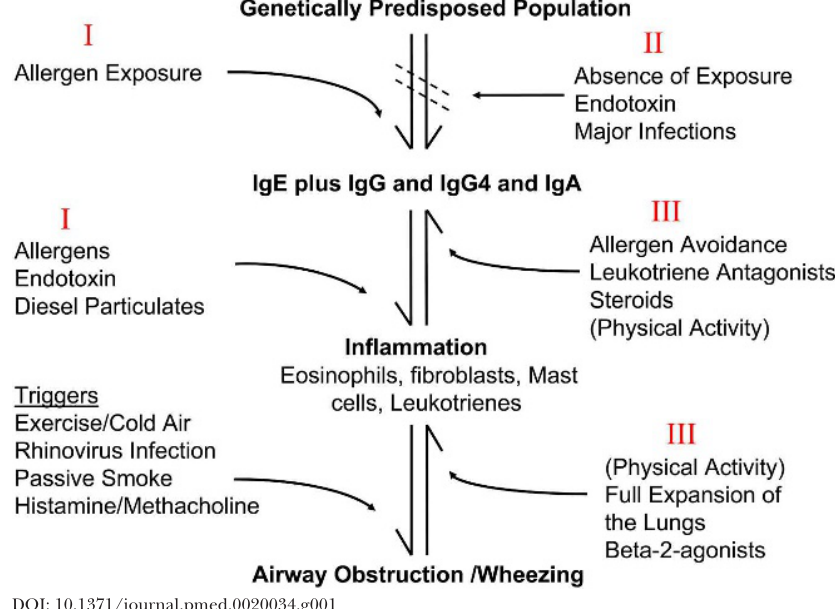
DOI: 10.1371/journal.pmed.0020034.g001 Figure 1. Sensitization, Infl ammation, and Wheezing Increases in prevalence/severity of asthma (reversible airway obstruction) could occur because of changes in different parts of the hypersensitivity and infl ammatory response in the lungs. The Roman numerals refer to the three hypotheses in Box